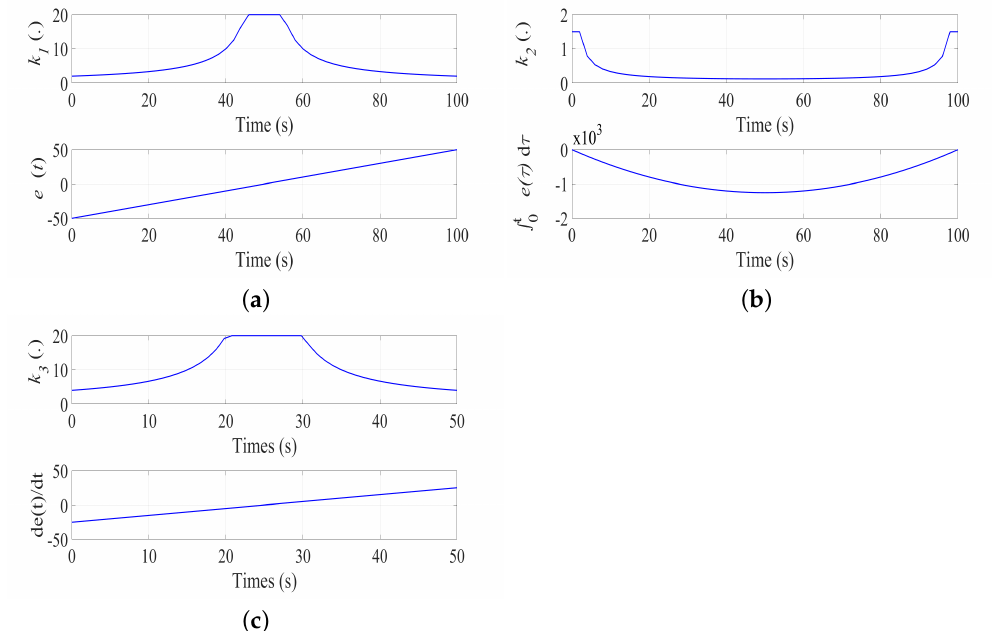
Figure 5. Plot of a variable gain obtained by Equations (22)–(24).